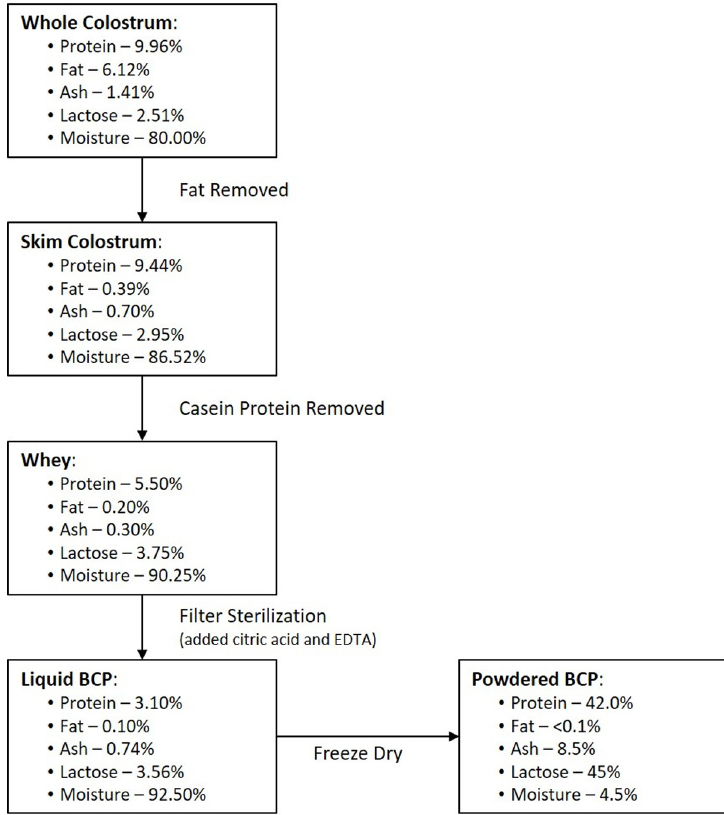
Fig 3. BCP work flow chart. Diagram describing work flow for bovine colostrum product (Imucon) production. The dried Imucon product (powdered BCP) was produced from the commercially available liquid Imucon product (liquid BCP) for specific use in the current